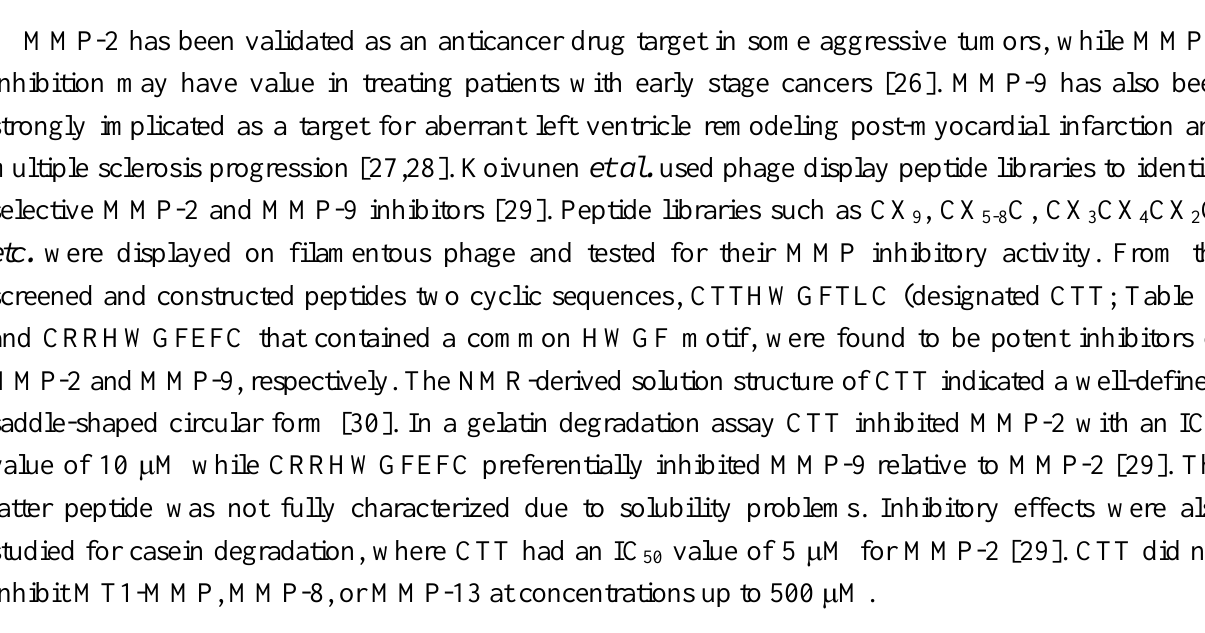
Table 1. Peptide-based Inhibitors of MMP-Mediated Activities. ND = not